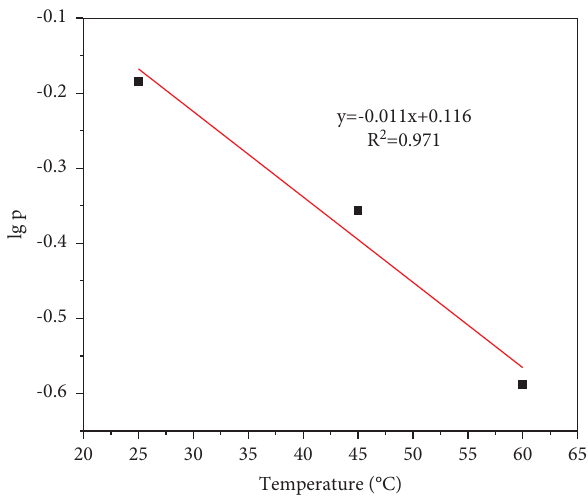
Figure 16: Variation of the logarithm of tensile strength with temperature.